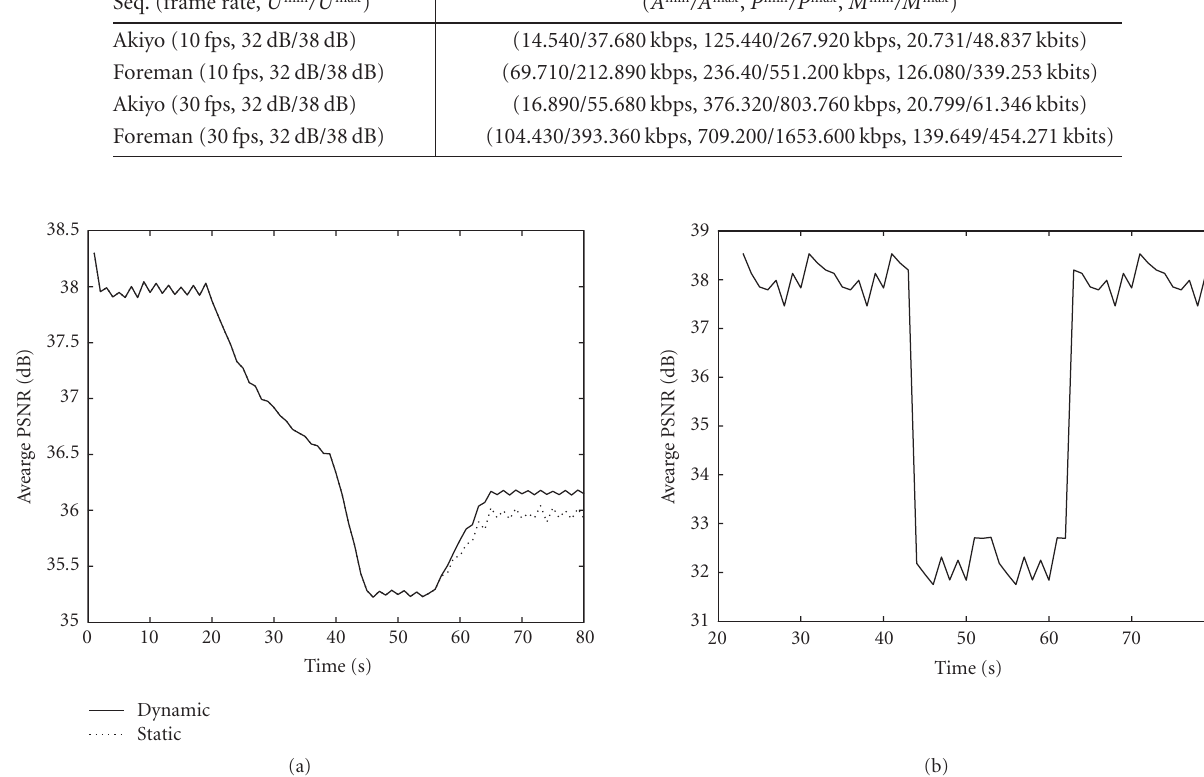
Figure 7: (a): the average PSNR. (b): the PSNR result of the 46th video